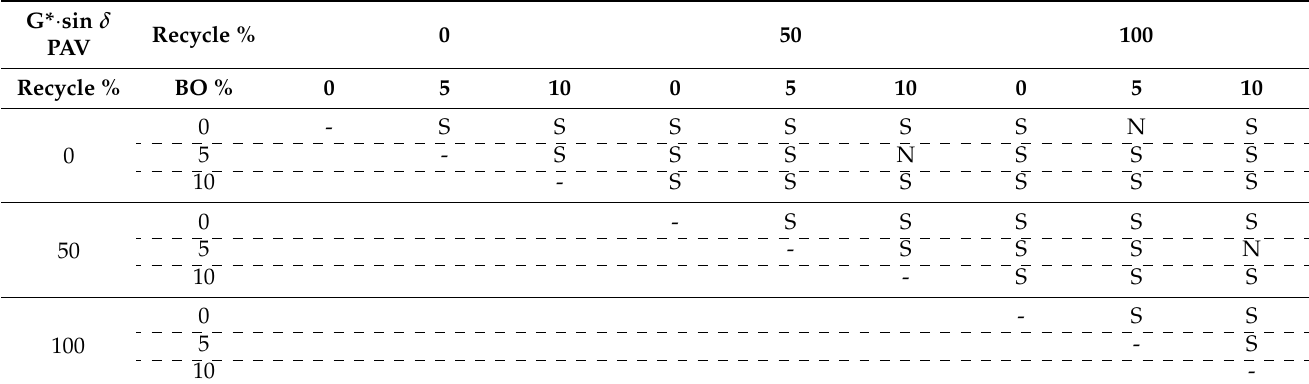
Table 6. Statistical analysis results of the G* · sin δ for RTFO + PAV condition as a function of aged binder contents and the addition of base oil ( α =